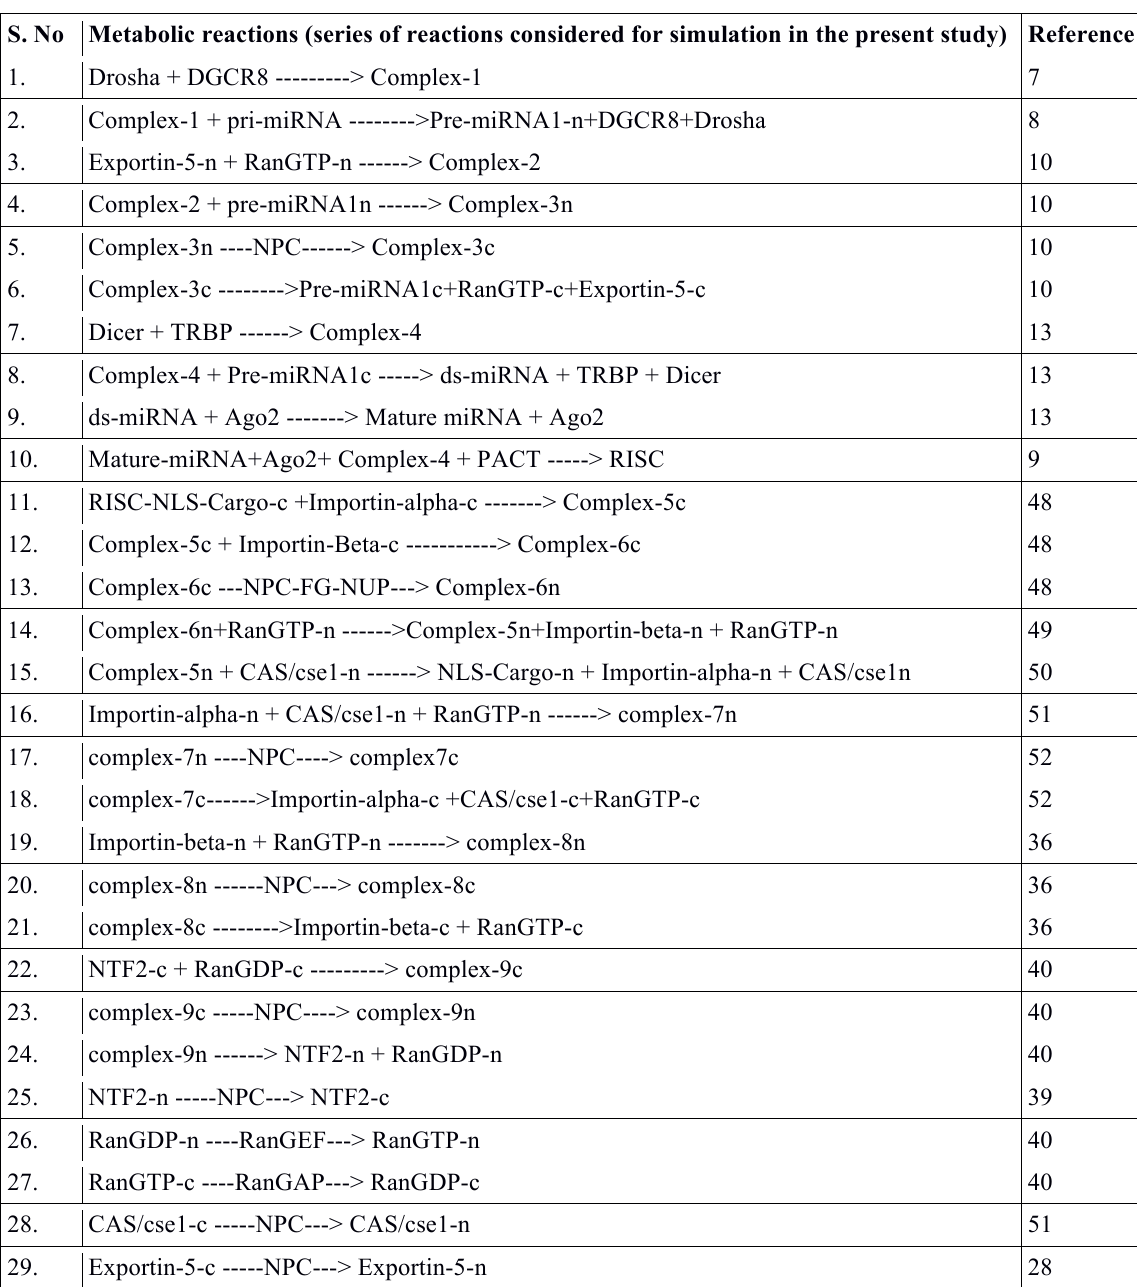
Table 1: Metabolic reactions used in